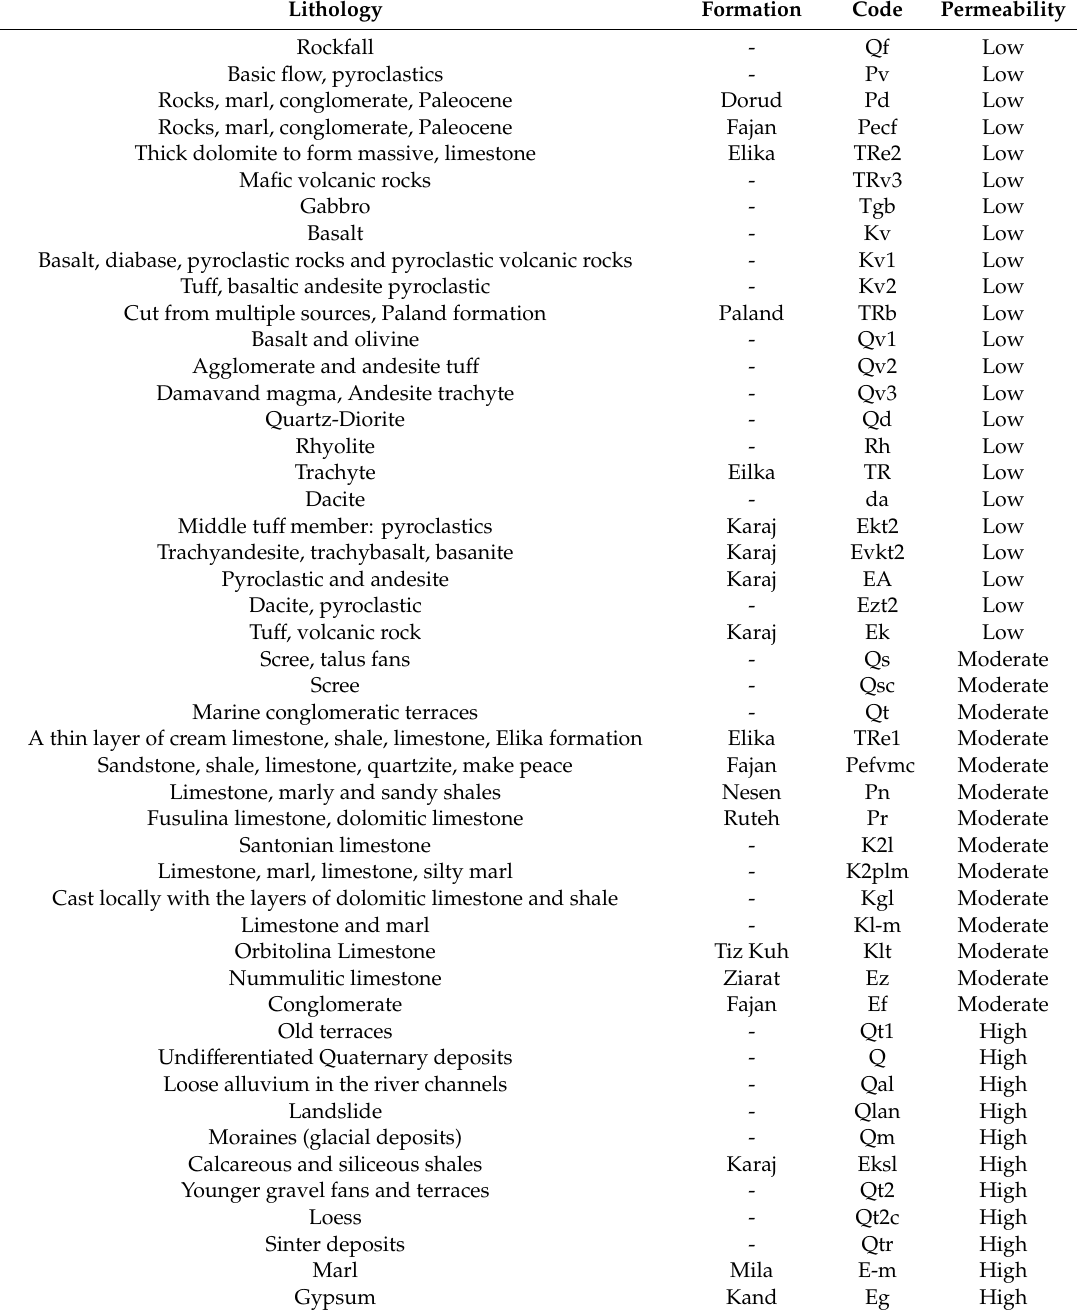
Table 2. The lithology of the Haraz Catchment. Lithology Formation Code Permeability